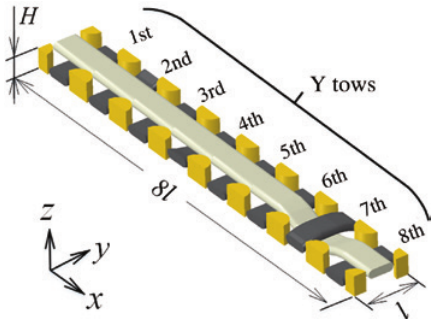
Table 1: Dimensions of ORUC (unit: